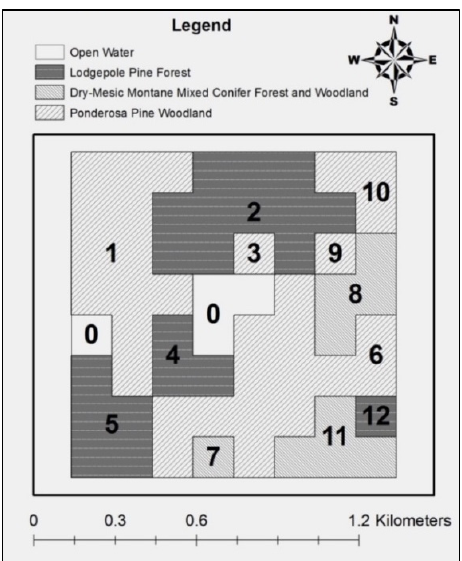
Figure 4. A synthesized landscape is created with 12 stands (stand ID from 1 to 12) and open water (with ID of zero) for testing purpose. All test cases assumed three ten ‐ year planning periods. In each period, zero to mul ‐ tiple randomly generated fires might occur. Random numbers were drawn to determine